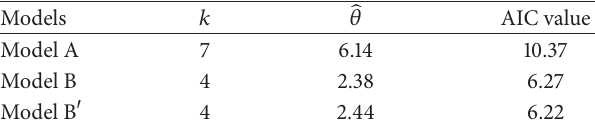
Table 8: AIC value of every model.